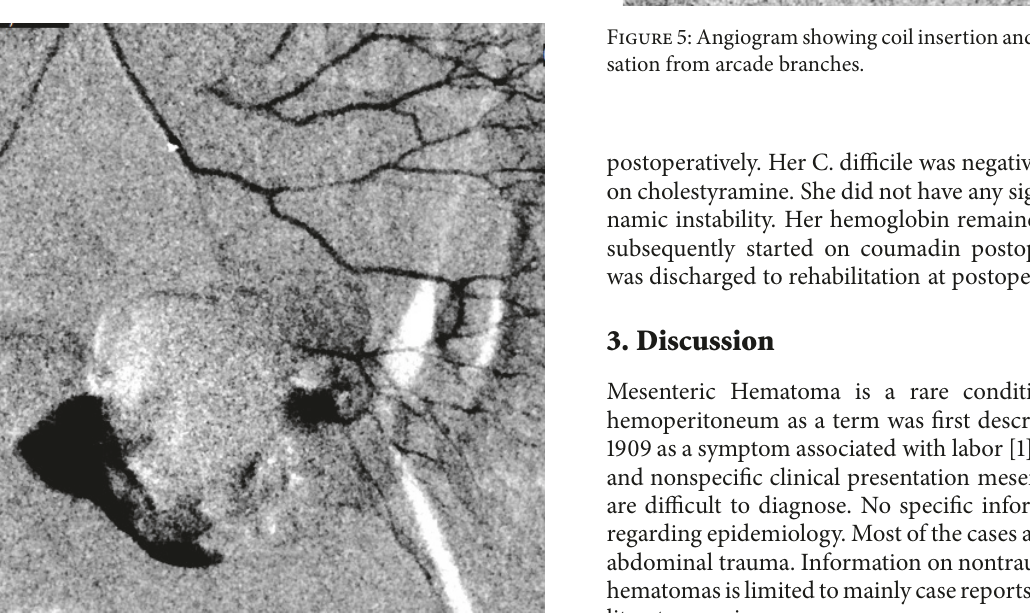
Figure 4: Angiogram showing extravasation from ileal branch of sma and early hematoma formation.